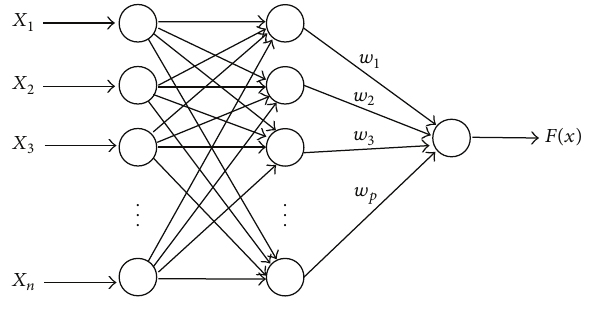
Figure 4: Structure of the